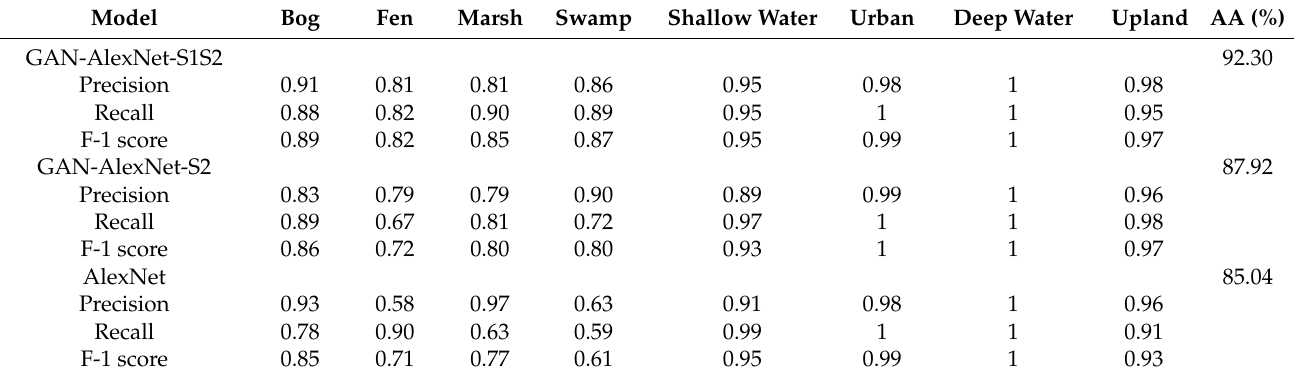
Table 4. Results of the developed machine learning of the proposed model in terms of precision, F1-score, and recall (S1 = Sentinel-1, S2 =